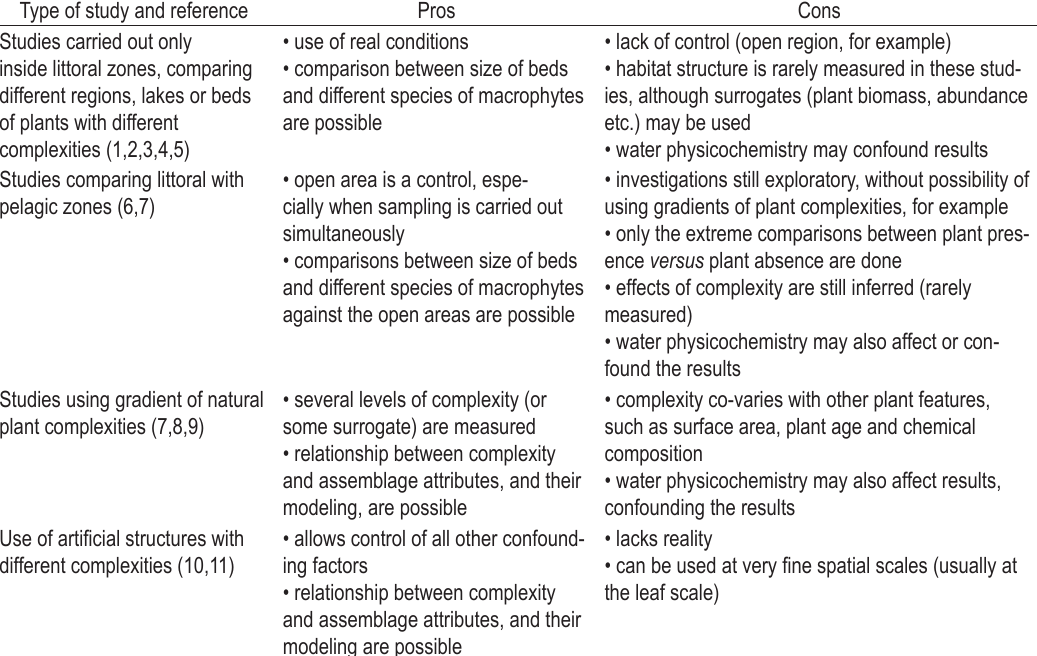
Table 1. Types of studies that measured the effect of macrophyte complexity on population and community attributes. Some references are given for